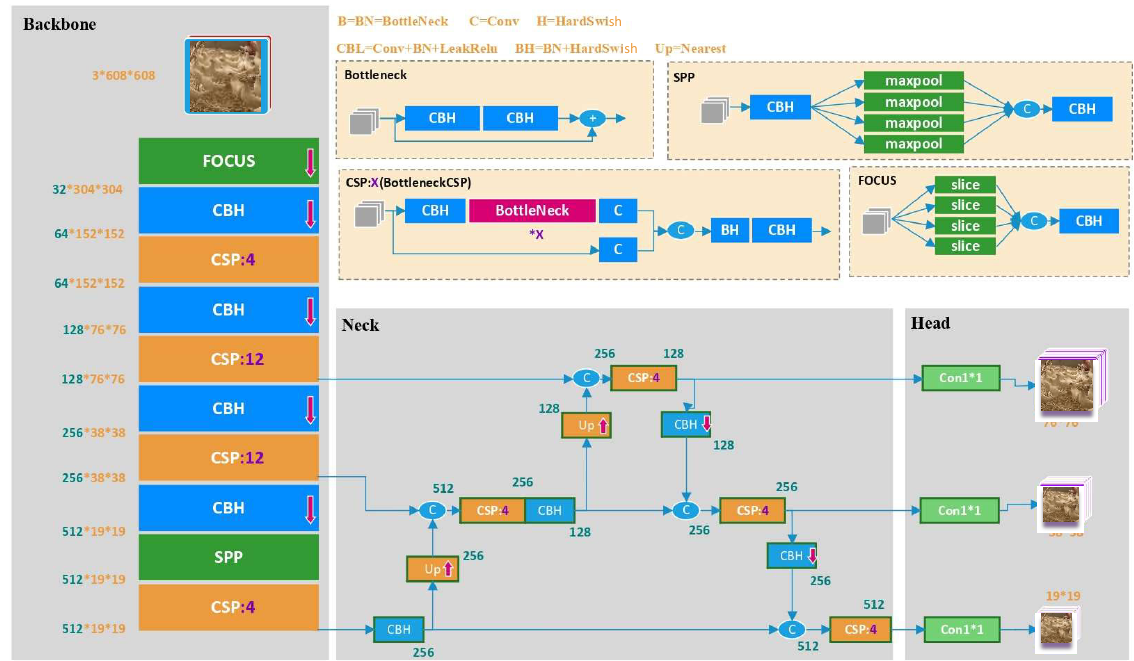
Table 1. The difference between YOLOv5 models.